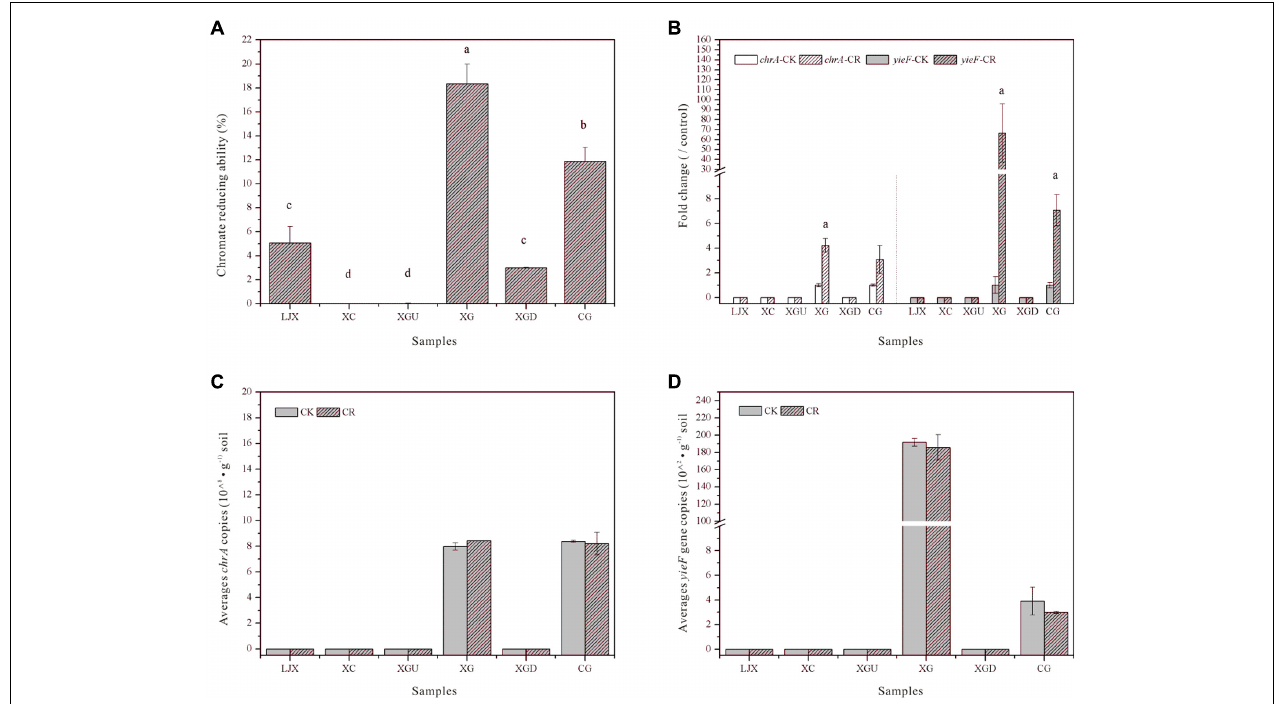
FIGURE 2 | (A) Cr (VI) reduction ability of soil samples from the six sites. (B) Expression of mRNA of chrA and yieF in riparian soil samples treated with 0.85% NaCl containing 0.5 mM K 2 Cr 2 O 7 for 30 min. The control group was treated with 0.85% NaCl only (CK). Mean expression in the treated group is shown as fold change compared to the mean expression in the control group, which has been ascribed an arbitrary value of 1. Significant difference at the p < 0.05 level is signified by a . (C) Copies of chrA in riparian soil samples incubated with 0.85% NaCl only (CK) and 0.85% NaCl containing 0.05 mM K 2 Cr 2 O 7 (CR) for 35 days. (D) Copies of yieF in the riparian soil sample incubated with 0.85% NaCl only (CK) and 0.85% NaCl containing 0.05 mM K 2 Cr 2 O 7 (CR) for 35 days. Values with different letters mean significant differences at p < 0.05, as determined by Tukey’s